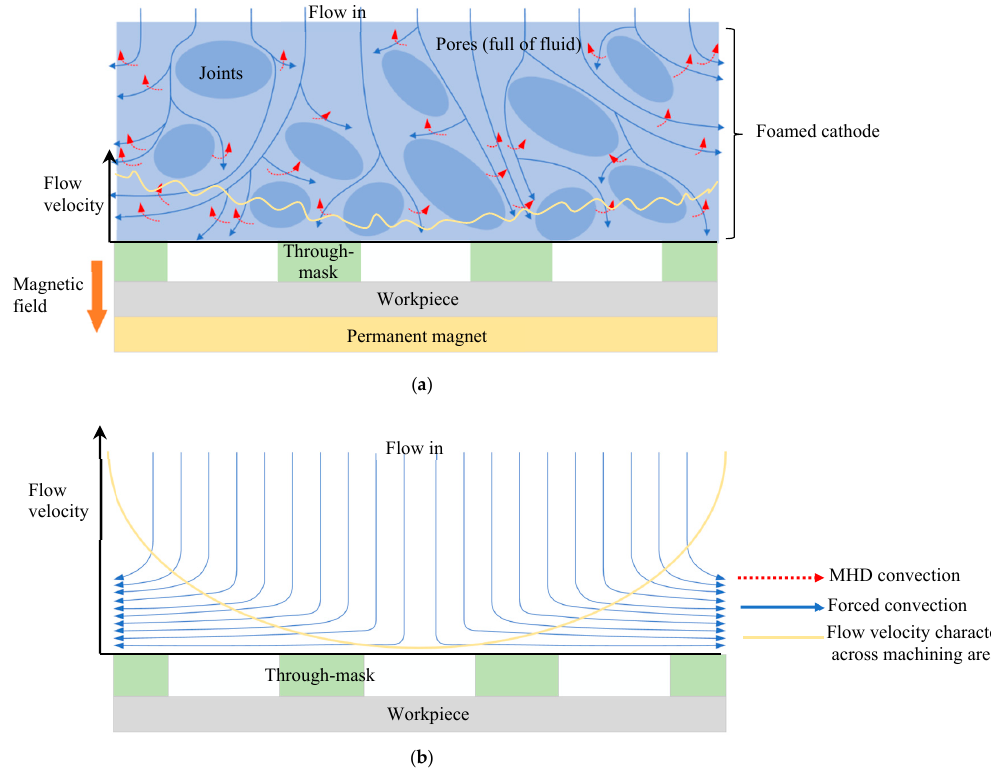
Figure 7. Change in dimensional CV of the arrayed micro ‐ dimples with or without the magnetic field (single ‐ travel time of 0.3 s).